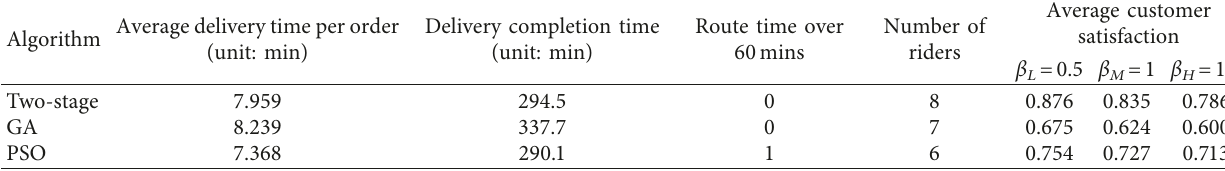
Table 5: Simulation results obtained by different algorithms. Average delivery time per order Algorithm (unit: